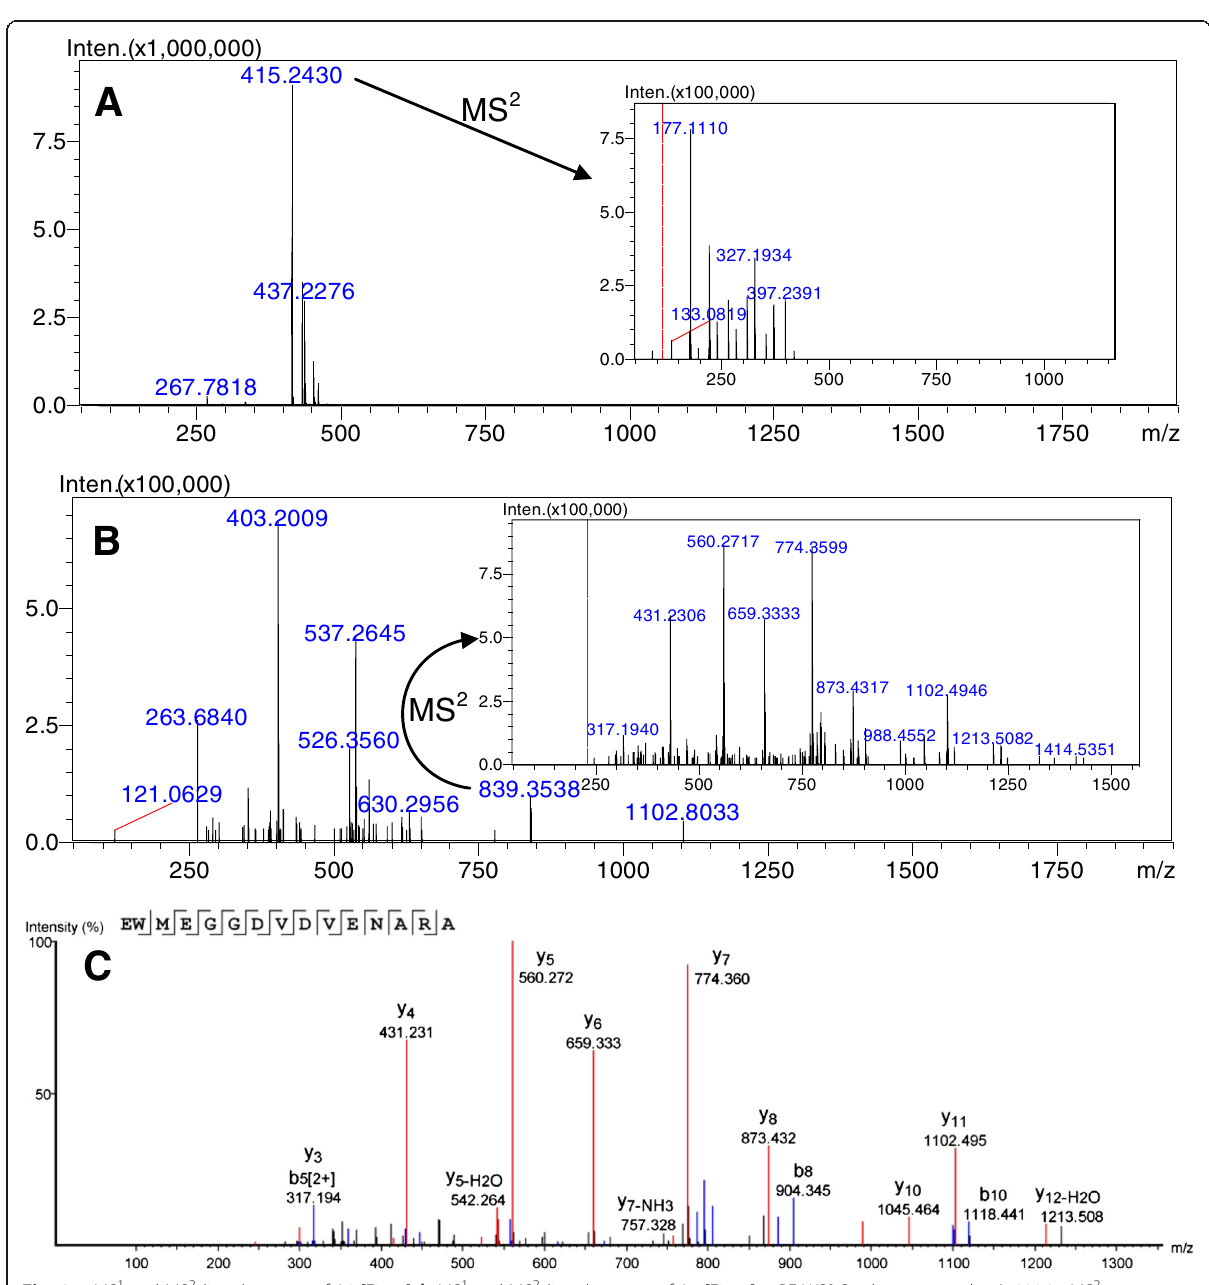
Fig. 3 a MS 1 and MS 2 (inset) spectra of A2 [Fig. 1]. b MS 1 and MS 2 (inset) spectra of A1 [Fig. 1]. c PEAKS® Studio processed m/z 839.35 MS 2